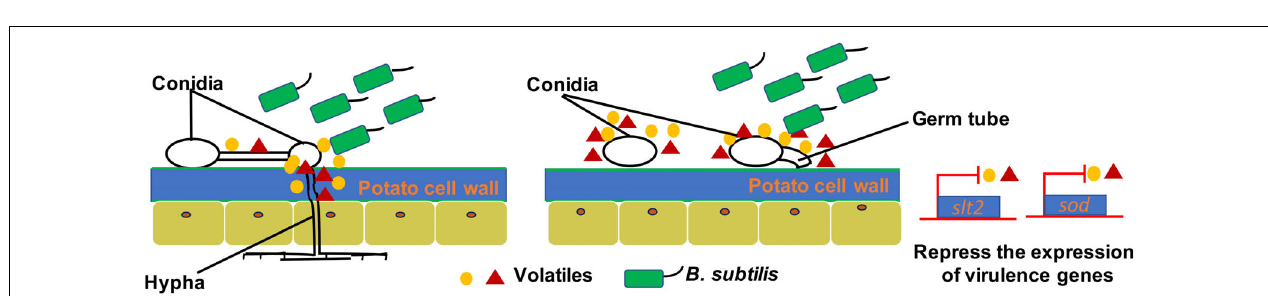
FIGURE 5 | slt2 and sod are key virulence related genes in A. solani. (A) Colony morphology of wild-type A. solani (WT), mutants ( (cid:49) slt2 and (cid:49) sod ) and complementation strains ( (cid:49) slt2- C and (cid:49) sod- C). (B) Mycelia penetration ability of wild-type A. solani (WT), mutants ( (cid:49) slt2 and (cid:49) sod ), and complementation strains ( (cid:49) slt2- C and (cid:49) sod- C). (C) Symptoms of early blight disease on potato leaf caused by sterile water (Control), wild-type A. solani (WT), mutants ( (cid:49) slt2 and (cid:49) sod ), and complementation strains ( (cid:49) slt2- C and (cid:49) sod- C). (D,E) Conidia production and colony diameter of wild-type A. solani (WT), mutants ( (cid:49) slt2 and (cid:49) sod ), and complementation strains ( (cid:49) slt2 -C and (cid:49) sod -C). (F) Lesion diameter early blight disease on potato leaf caused by wild-type A. solani (WT), mutants ( (cid:49) slt2 and (cid:49) sod ), and complementation strains ( (cid:49) slt2- C and (cid:49) sod- C). (G) SOD contents in wild-type A. solani (WT), mutants ( (cid:49) slt2 and (cid:49) sod ), and complementation strains ( (cid:49) slt2- C and (cid:49) sod- C). (H) Transcriptional expression profiles of slt2 and sod after co-culture with ZD01 VOCs for 3 and 4 days. WT represents A. solani without treatment of ZD01 VOCs; ZD01 represents A. solani with treatment of ZD01 VOCs. Data presented are the mean ± s.d. ( n = 3). The same letter on the bars for each column indicates no significant difference according to a LSD test at P = 0.05.